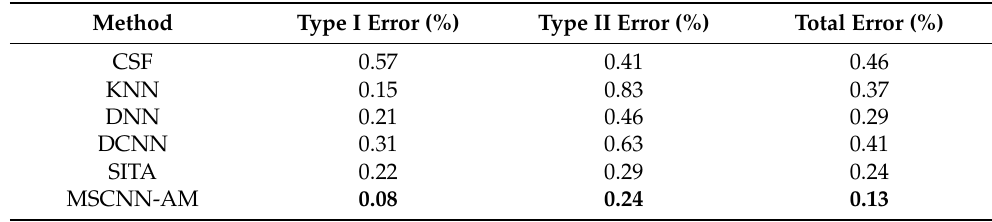
Table 5. Comparison of the filtering performance of six different filtering methods upon the dataset of Qinghai.